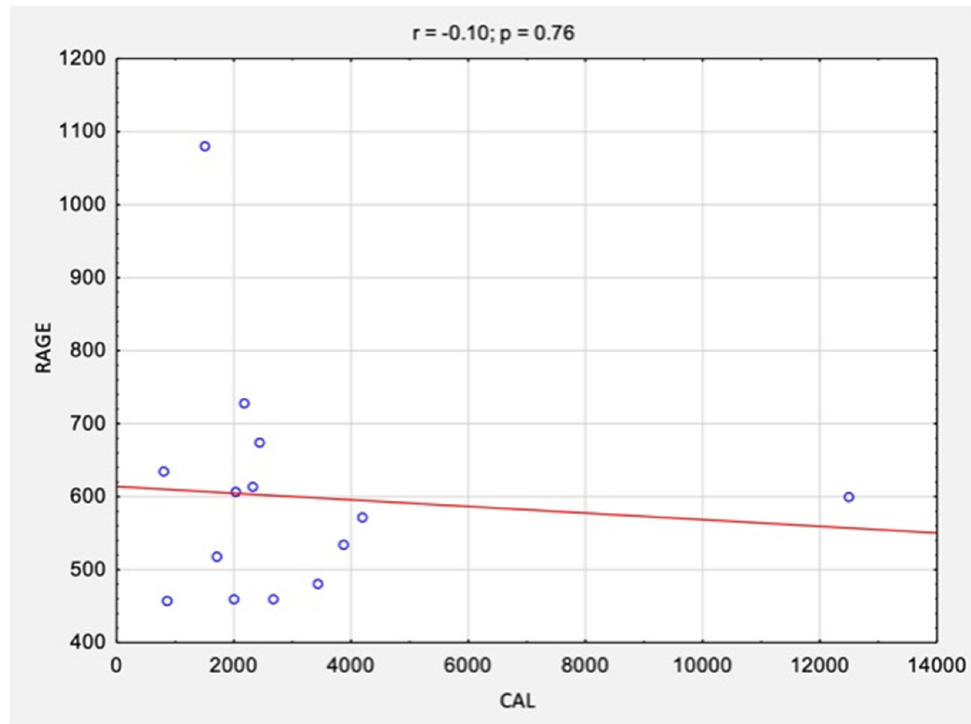
Figure 4. The correlations between the results of CAL levels and RAGE/AGER levels before surgical treatment. Abbreviations: r, Spearman’s correlation coefficient; n, number of participants; p, level of statistical significance; CAL, calprotectin; RAGE, receptor for advanced glycation end products.